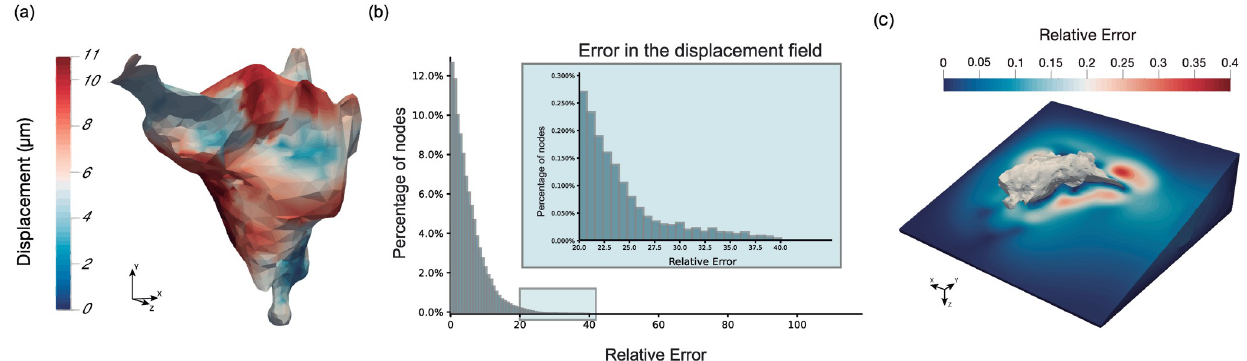
Fig 6. Measurements of displacements obtained. (a) Displacement ( μm ) field obtained at the cell surface. (b) Displacement error distribution. The maximum relative error obtained is 39.95%. The error obtained at the 90th percentile is 11.28%. Maximum errors (higher than 35%) appear in less than 0.05% of the nodes. (c) Relative error plotted all over the ECM.